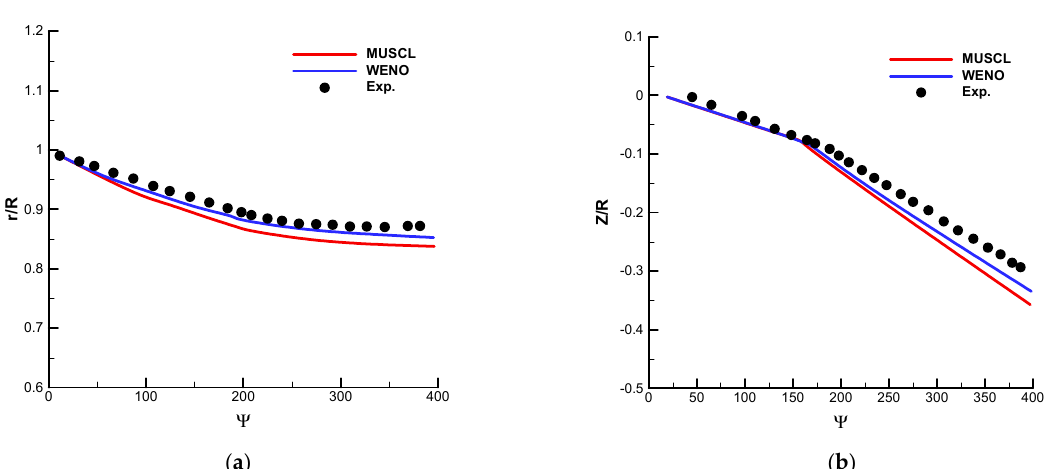
Figure 13. Comparison of positions of vortex coresduring a full rotor rotation in the radial and axial directions. ( a ) radial position, ( b ) axial position.